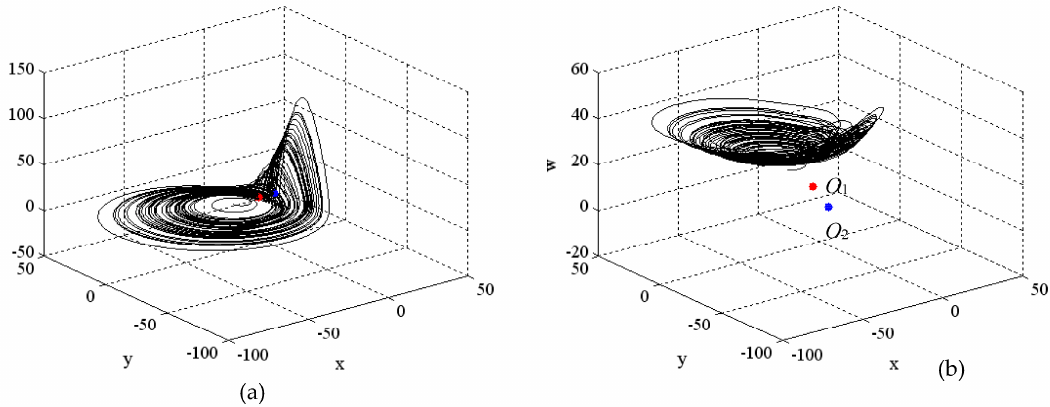
Figure 4. Phase space of system (2) in hyperchaotic regime, when ( a , b ) a = 0.25, b = 3, c = 0.5, d = 0.05, b 1 = 0.2, b 2 = − 0.3, b 3 = 0.2, b 4 = 0.01. The first equilibrium O 1 is marked with red color and the second equilibrium O 2 is marked with blue